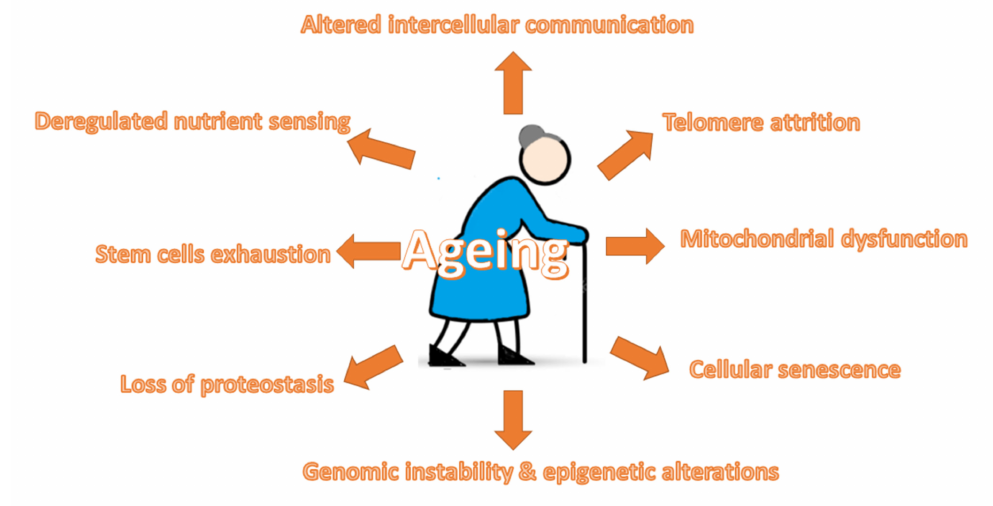
Figure 1. Mechanisms involved in